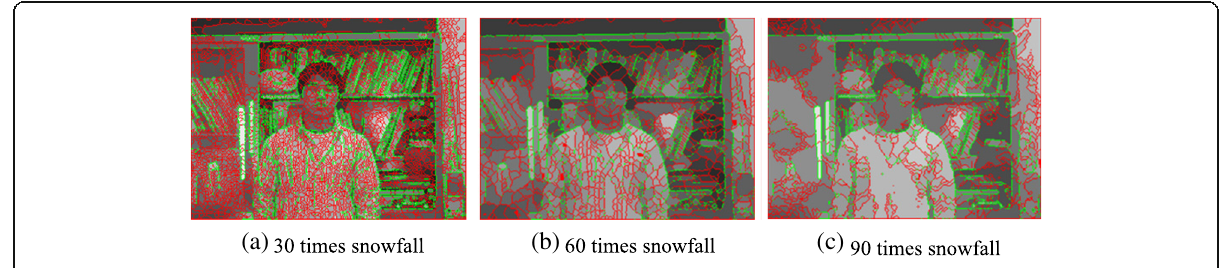
Fig. 9 Region segmentation results based on the snowfall model. a 30 times snowfall. b 60 times snowfall. c 90 times snowfall